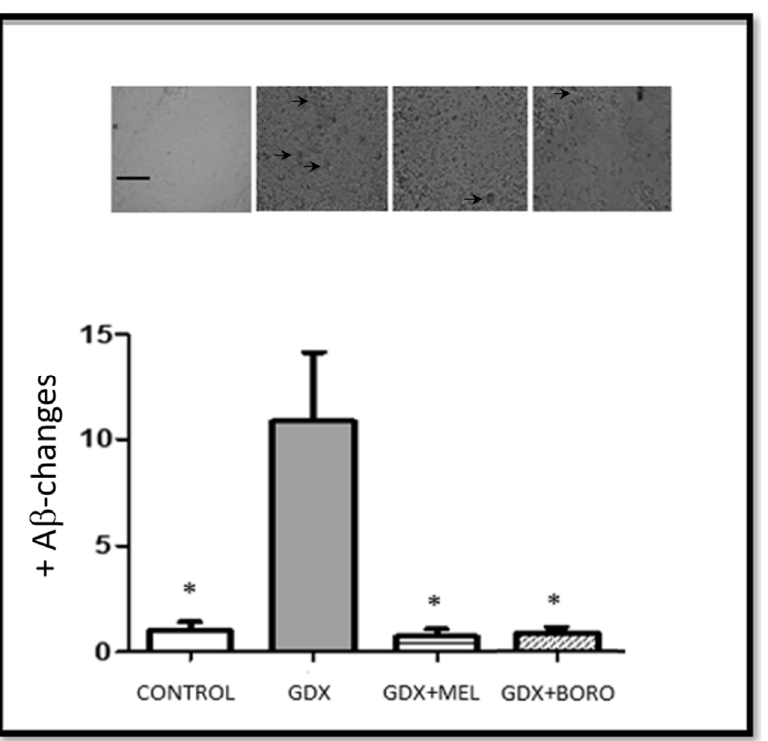
Figure 10. Neuronal survival. Above are photomicrographs of NeuN positive labeling observed in the hippocampus. Magnification 40×. Scale bar represents 100 μ m. In the plot the columns represent the number of NeuN-positive neurons, bars represent SEM. Significant differences in groups com- pared with the control group ( n = 4, * p < 0.01); GDX, gonadectomized; MEL, melatonin; BORO, Borolatonin.